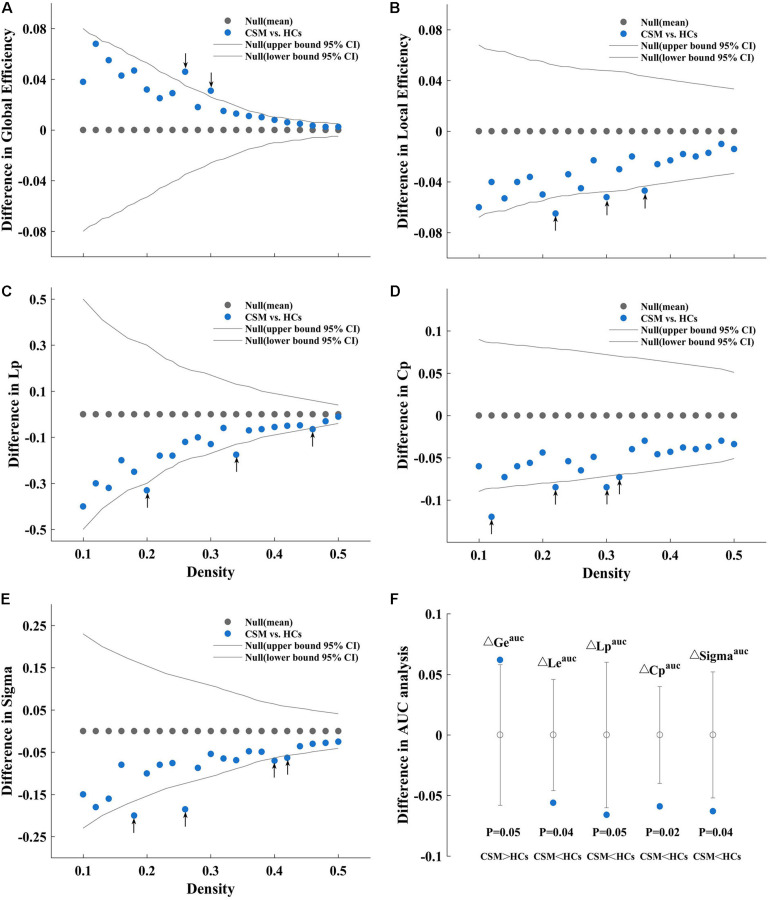
Between-group differences in global efficiency (A), local efficiency (B), characteristic path length (Lp) (C), clustering coefficient (Cp) (D), and Sigma (E) as a function of density. Between-group differences in areas under the global efficiency (ΔGeauc), local efficiency (ΔLeauc), Lp (ΔCpauc), Cp (ΔLpauc), and Sigma (ΔSigmaauc) curves (F), from left to right sequentially). As an example, we have described (A). (A) Denotes the differences (azure dots) in the global efficiency between the patients with cervical spondylotic myelopathy (CSM) and the healthy controls (HCs) as a function of density thresholds. The gray dots represent the mean values and the gray lines represent the 95% confidence intervals of the between-group differences obtained 1000 permutation tests at each density value. The black arrows indicate significant difference in global efficiency between the two groups (P < 0.05). Patients with CSM show larger global efficiency in the brain structural covariance networks than HCs at thresholds 0.26 and 0.30. Similarly, (B) denotes that patients with CSM show smaller local efficiency in the brain structural covariance networks than HCs at threshold 0.22, 0.30, and 0.36. (C) Denotes that patients with CSM show smaller Lp in the brain structural covariance networks than HCs at threshold 0.20, 0.34, and 0.46. (D) Denotes that patients with CSM show smaller Cp in the brain structural covariance networks than HCs at threshold 0.12, 0.22, 0.30, and 0.32. (E) Denotes that patients with CSM show smaller Sigma in the brain structural covariance networks than HCs at thresholds 0.18, 0.26, 0.40, and 0.42. (F) Denotes that patients with CSM show significantly larger Geauc (P = 0.05) and smaller Leauc (P = 0.04), Lpauc (P = 0.05), Cpauc (P = 0.02), and Sigmaauc (P = 0.04) in the brain structural covariance networks than HCs in the areas under curve (AUC) analysis.